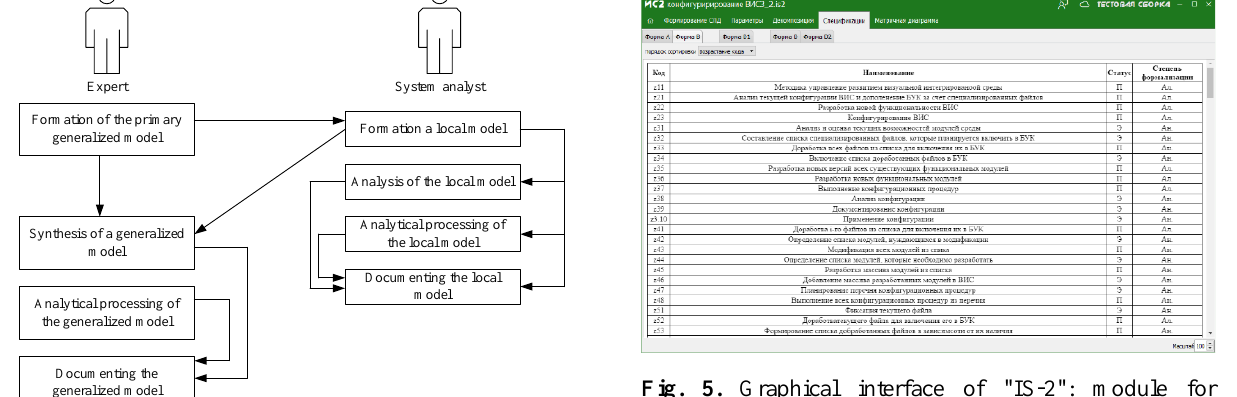
Fig. 5. Graphical interface of "IS-2": module